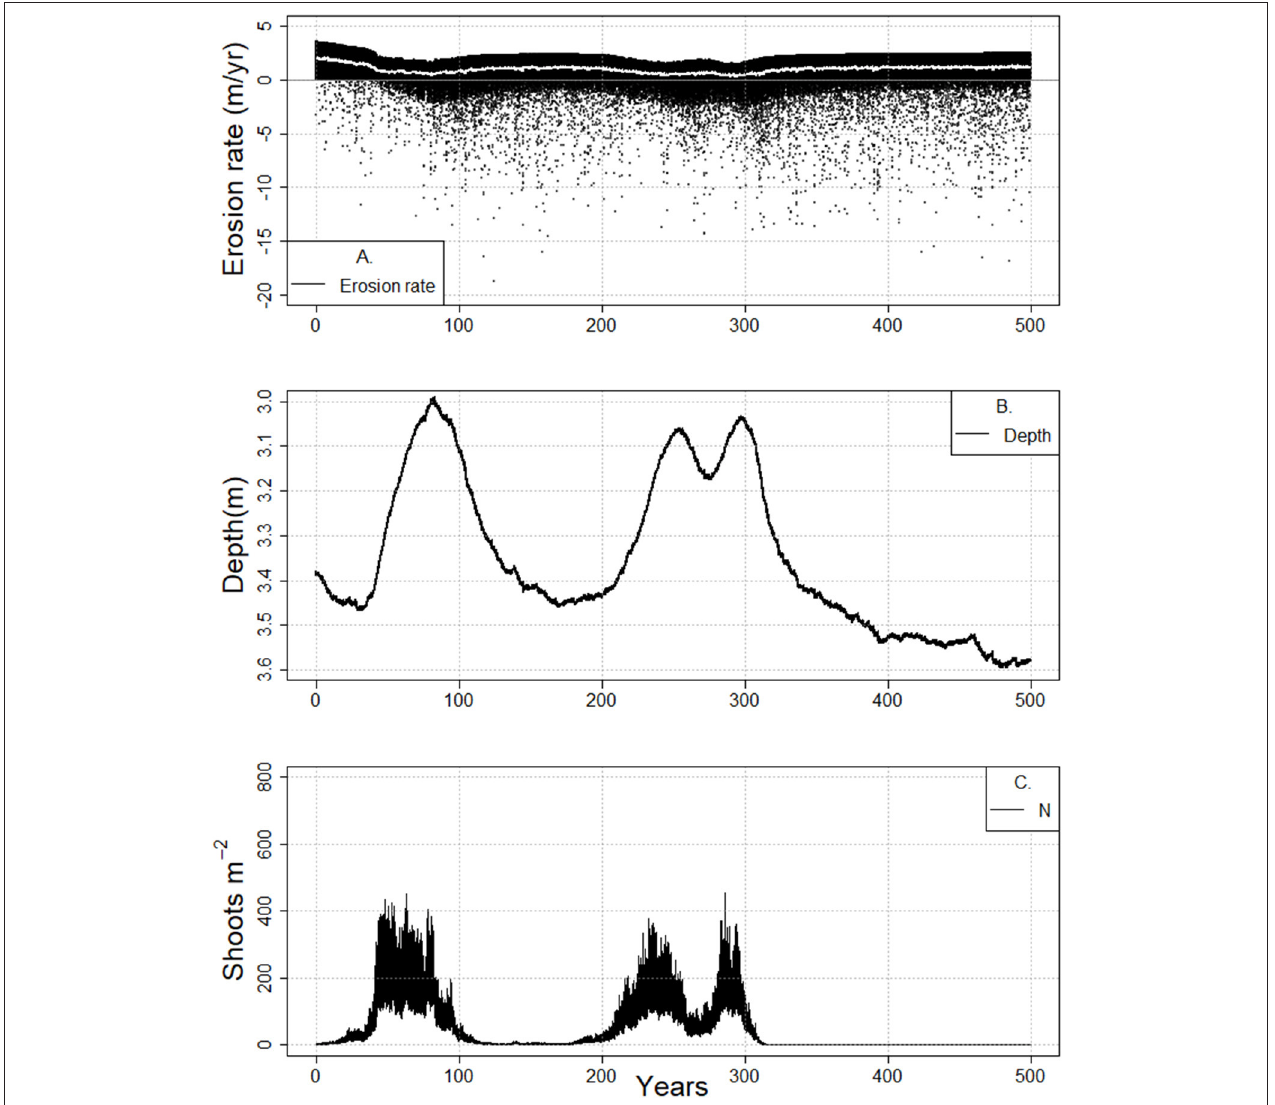
FIGURE 8 | Cyclical meadow behavior and concurrent changes in tidal flat erosion rate (A) , tidal flat depth (B) , and shoot density (C) during the 500-year-long model runs (RSLR 4mm year − 1 , Co = 30 mg/L, b f = 5.25km). Decadal to half century long cycles of this behavior are